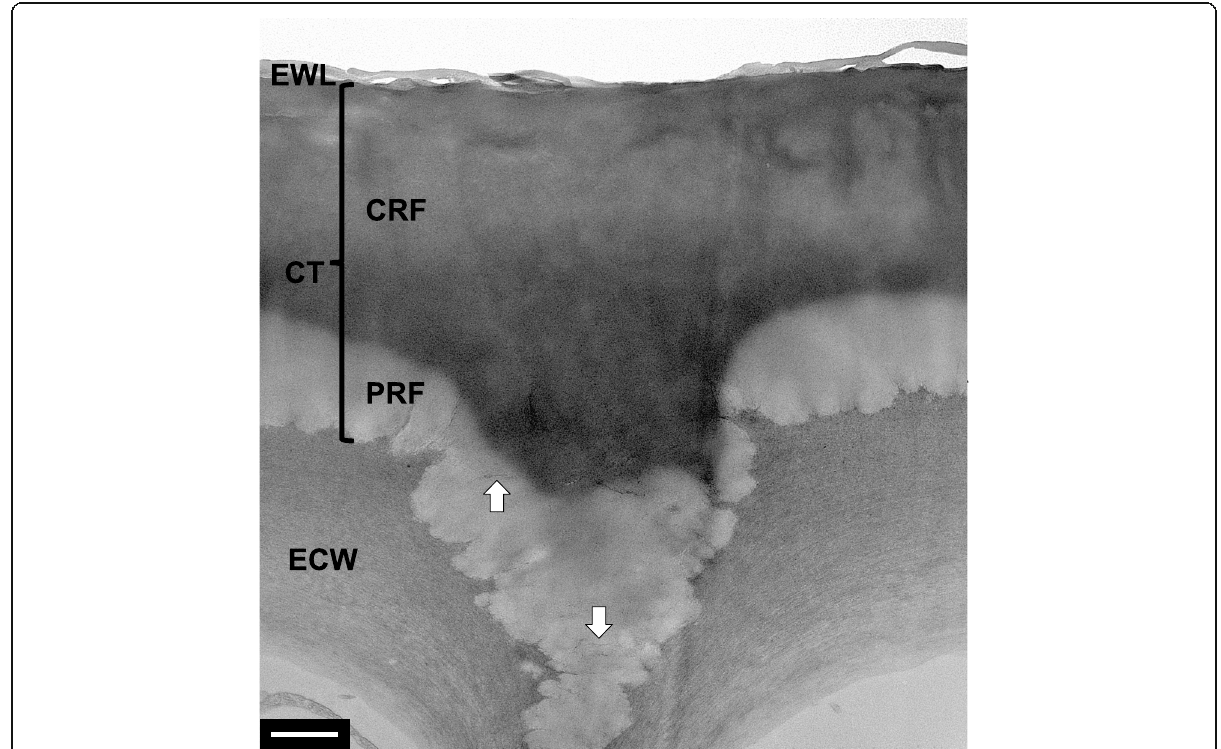
Fig. 1 Transmission electron micrograph of the heterogeneous cuticle in the leaf epidermis of Ficus elastica . A polysaccharide-rich fraction and a cutin-rich fraction constituted the cuticle. Arrows = cellulose fibrils. CRF = cutin-rich fraction. CT = cuticle. ECW = epidermal cell wall. EWL = epicuticular wax layer. PRF = polysaccharide-rich fraction. Bar = 1 μ